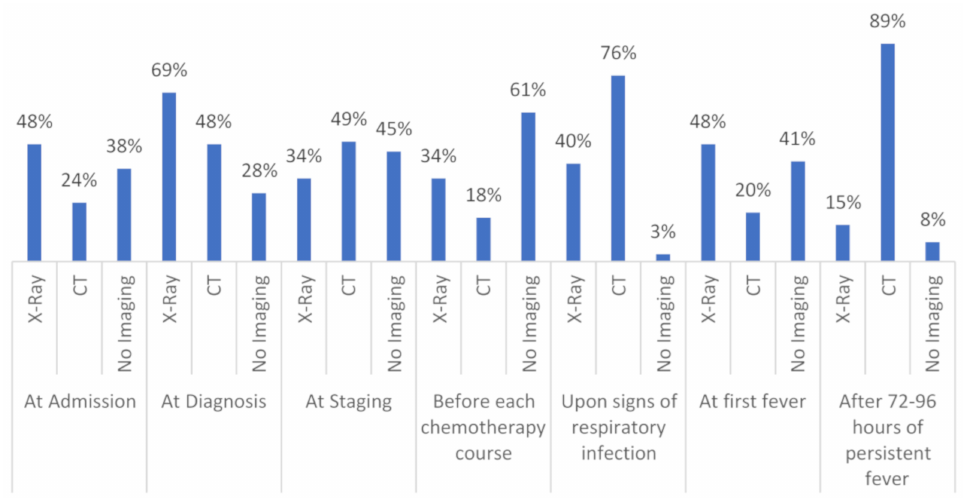
Figure 2. Shows the di ff erent timepoints and techniques of chest imaging in high-risk hematology patients in detail; n = 95. CT = computed